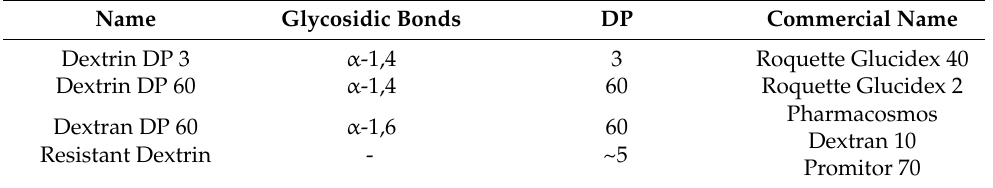
Table 1. Four samples with structure (glycosidic bonds), degree of polymerization (DP), and com- mercial